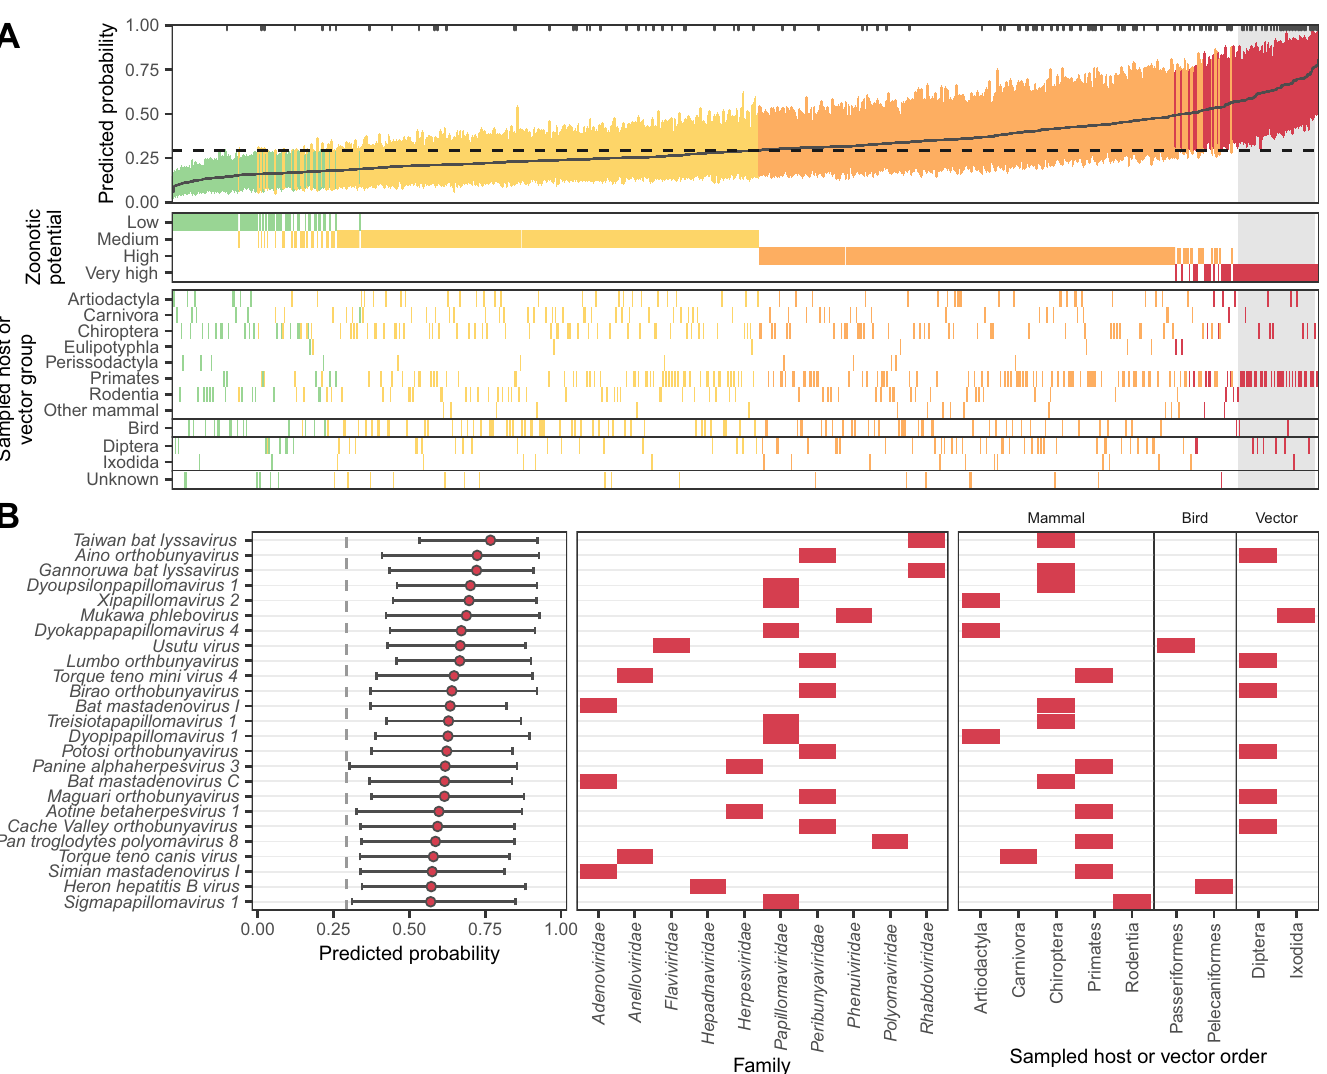
Fig 3. Probability of human infection predicted from holdout viral genomes. (A) Predicted probability of human infection for 758 virus species that were not in the training data. Colors show the assigned zoonotic potential categories, with an additional panel showing the host or vector group each virus genome was sampled from. Tick marks along the top edge of the first panel show the location of virus genomes sampled from humans, while a dashed line shows the cutoff that balanced sensitivity and specificity in the training data. The top 25 viruses that were not sampled from humans (contained within the gray box) are illustrated in more detail in (B) . Bars show the 95% interquartile range of predicted probabilities across the best performing 10% of iterations (based on the training data), while a solid line (A) or circles (B) show the mean predicted probability from these iterations. Numerical data underlying this figure can be found in S1 Table and at https://github.com/nardus/zoonotic_ rank/tree/main/FigureData (doi: 10.5281/zenodo.4271479).